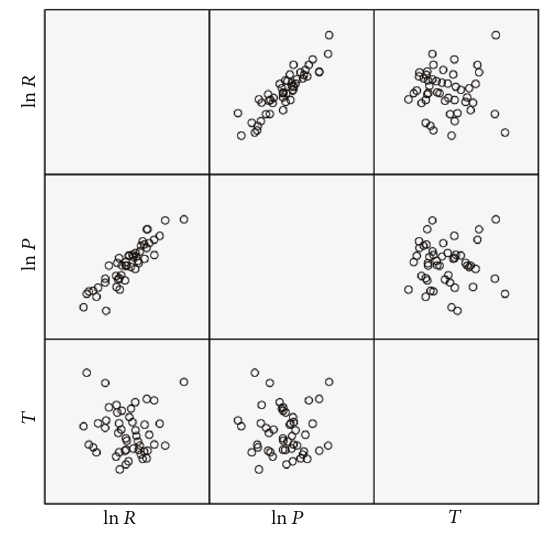
Figure 8: Scatter matrix of ln 𝑅 , ln 𝑃 , and